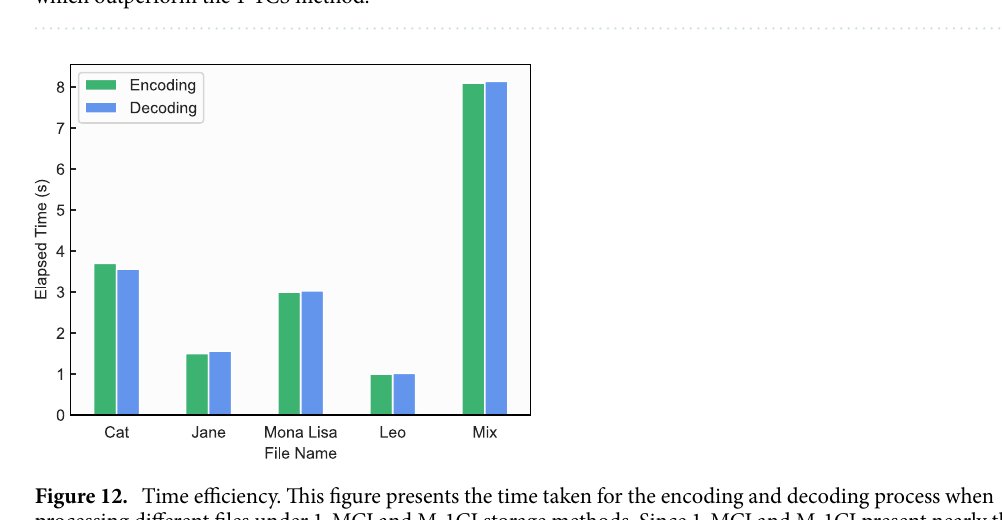
Figure 11. Storage density. ( a ) presents the storage density d = S o / S b when storing different files using three methods. In the ideal case, only the compressed data will be stored and its compressor will be ignored. Note that the M-1CI and 1-MCI methods present the same storage density performance, hence they are represented using only one bar. Thanks to the avoidance of the data redundancy, the 1-MCI and M-1CI method demonstrate higher storage density compared with the 1-1CS. ( b ) shows the storage density of these methods when storing all the data. Again in this case, both 1-MCI and M-1CI present nearly the same storage density performance, which outperform the 1-1CS method.